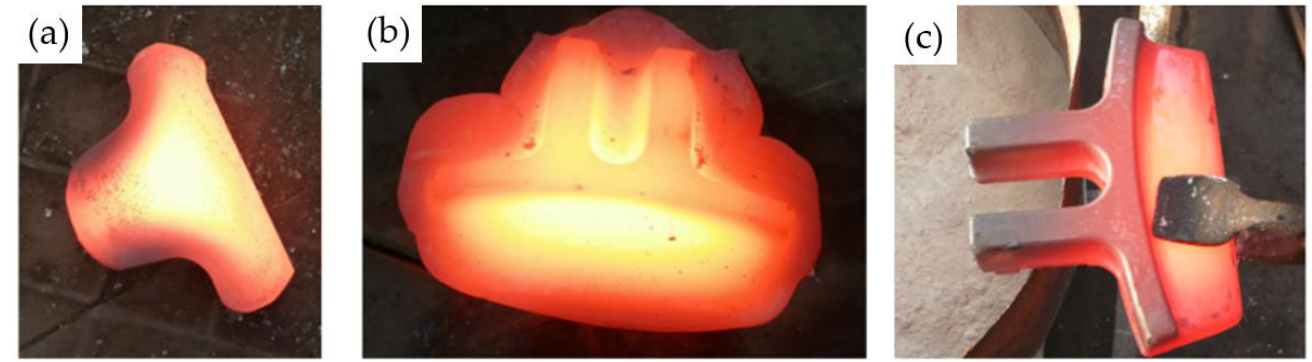
Figure 16. Hot forging product during forming process. ( a ) T-shaped blank; ( b ) product after final forging; ( c ) forgings after trimming.